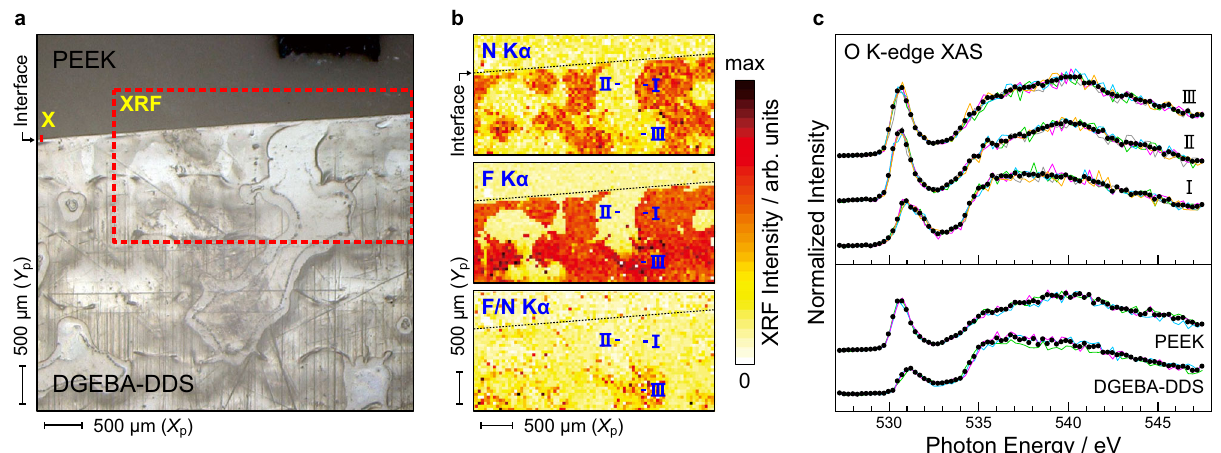
Fig. 2 Soft X-ray imaging of the DGEBA-DDS/PEEK cross-section. a An optical microscope image of the DGEBA-DDS/PEEK cross-section. XRF images were measured in the dashed-square region. The XAS spectra in Fig. 3 were measured at region X. b N K α and F K α images at hv = 780 eV. To identify the contrast difference between the N K α and F K α images, the F K α image was normalized by the N K α image (labeled F/N K α ). The interface region is indicated by the dashed line. c The upper panel shows O K-edge XAS spectra at regions I, II, and III. XAS spectra (colored thin solid curves) were measured at fi ve different neighboring spots, and the dotted curve indicates their averaged data. The lower panel shows XAS spectra for the PEEK and DGEBA-DDS bulk materials.